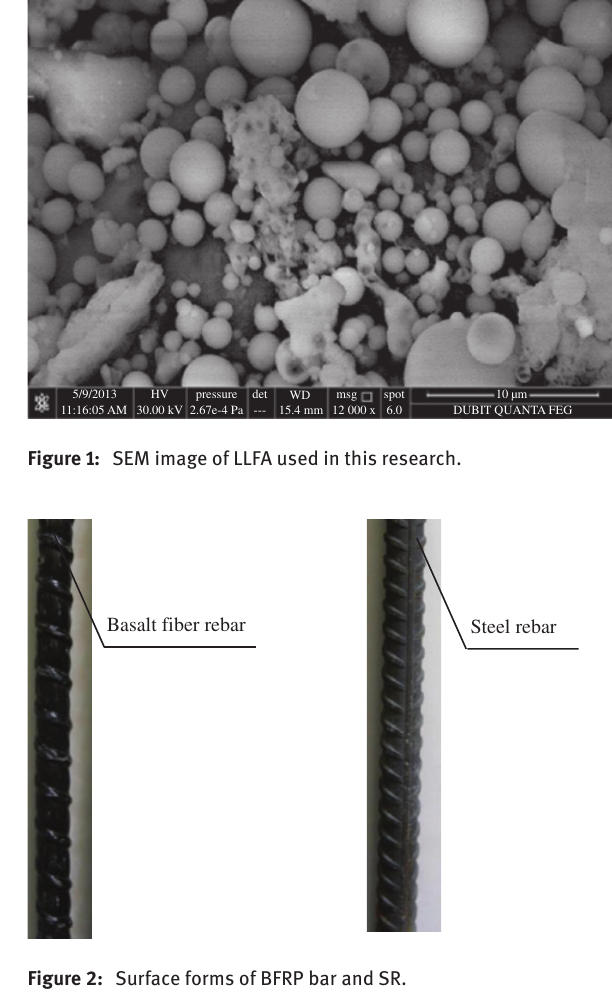
Figure 2: Surface forms of BFRP bar and SR.